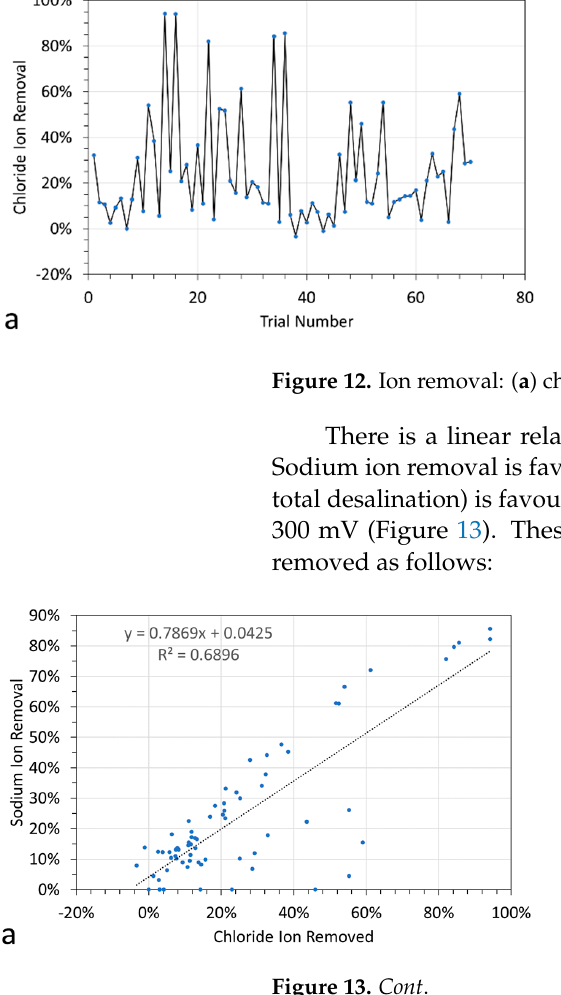
Figure 13. Ion removal: ( a ) chloride vs. sodium; ( b ) sodium vs. Eh; ( c ) chloride vs. Eh; ( d ) NaCl vs. Eh. 4.5. Predicting NaCl Removal The control trial indicated that no desalination occurred when no air was bubbled through the reactor. Therefore, the desalination is either a direct result of a chemical reac ‐ tion involving O 2 and Na + + Cl − ions, or a function of the pressure wave created by the rising air within the bubble column (Figure 14).